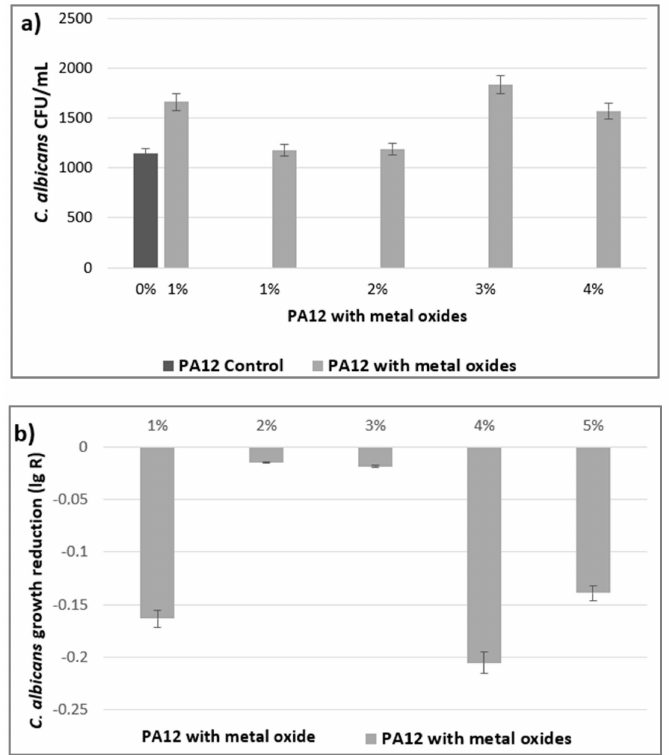
Figure A2. ( a , b ). Antifungal activity of the PA12 with metal oxides assessed using the PN-EN ISO 20743 2013-10E quantitative method.Legend: lg R was calculated using Equation: lg A − lg B = lg R, where A means CFU recovered from the PA12 control (without metal oxide) inoculated with C. albicans and incubated over the 24-h contact period; B means CFU recovered from the PA12 with metal oxide inoculated with C. albicans and incubated over the 24-h contact period.